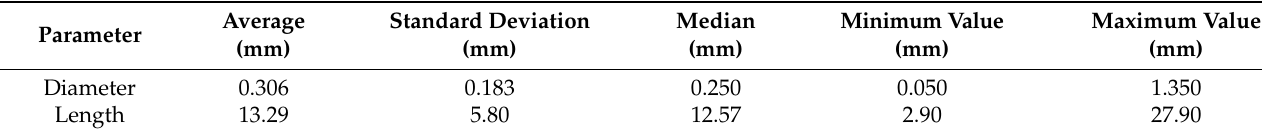
Table 2. The parameters of recycled steel